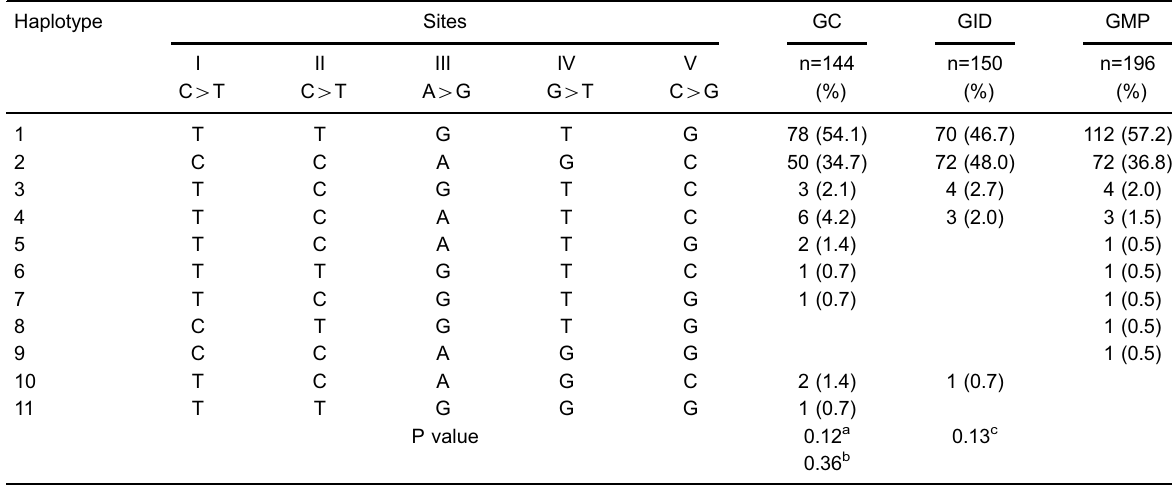
Table 2. Haplotypes observed in the studied groups.